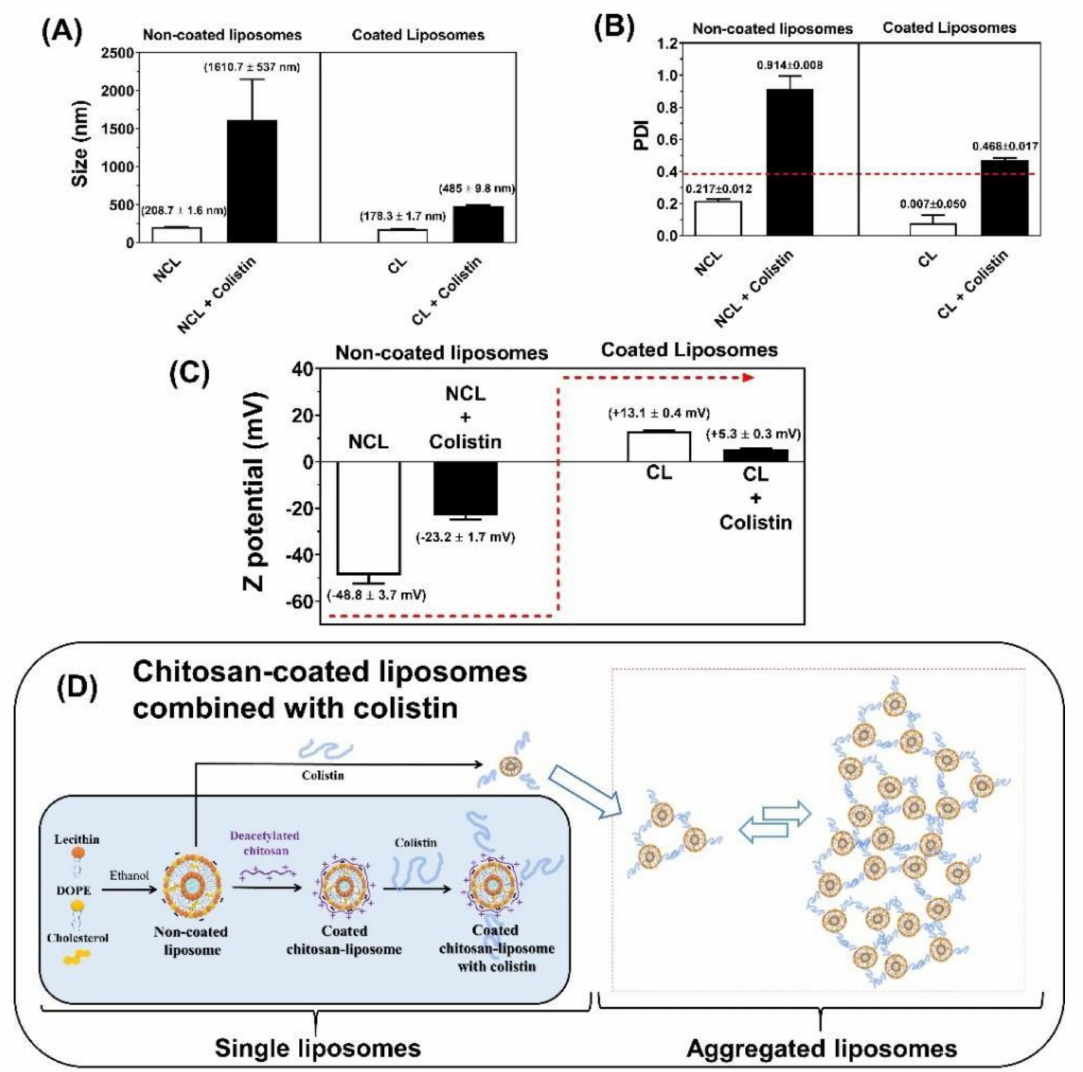
Figure 2. Physicochemical characterization of uncoated and chitosan-coated liposomes in the presence and absence of CST. ( A ) Particle size, ( B ) Polydispersity index-PDI, ( C ) Zeta potential, ( D ) Schematic representation of the liposomal coating process and its interaction with CST. NCL—Non-coated liposomes; CL—coated